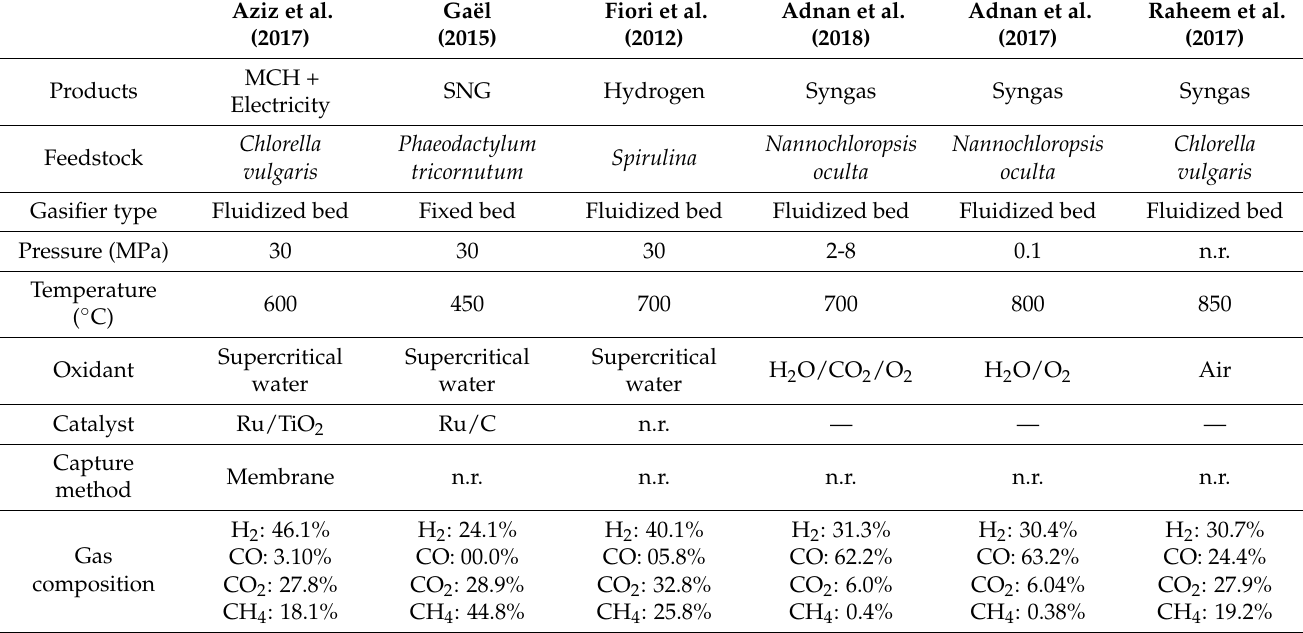
Table 3. Summary of previous literature on microalgae gasification [10,12,17,26–28].